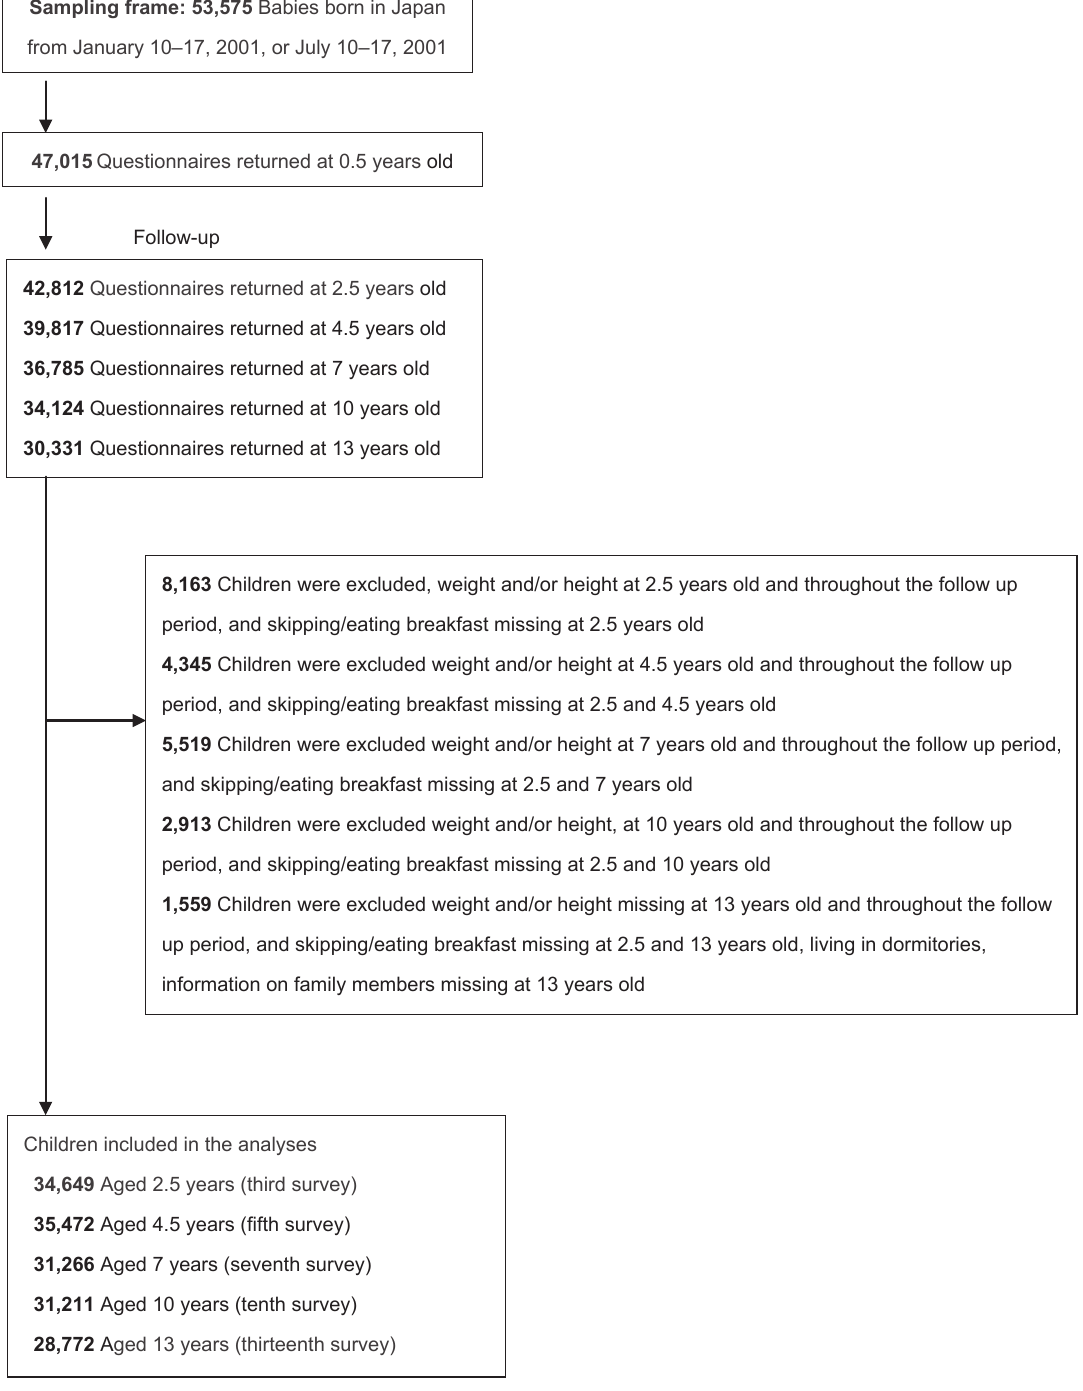
Figure 1. Flow diagram for selection of participant children from 2001 to